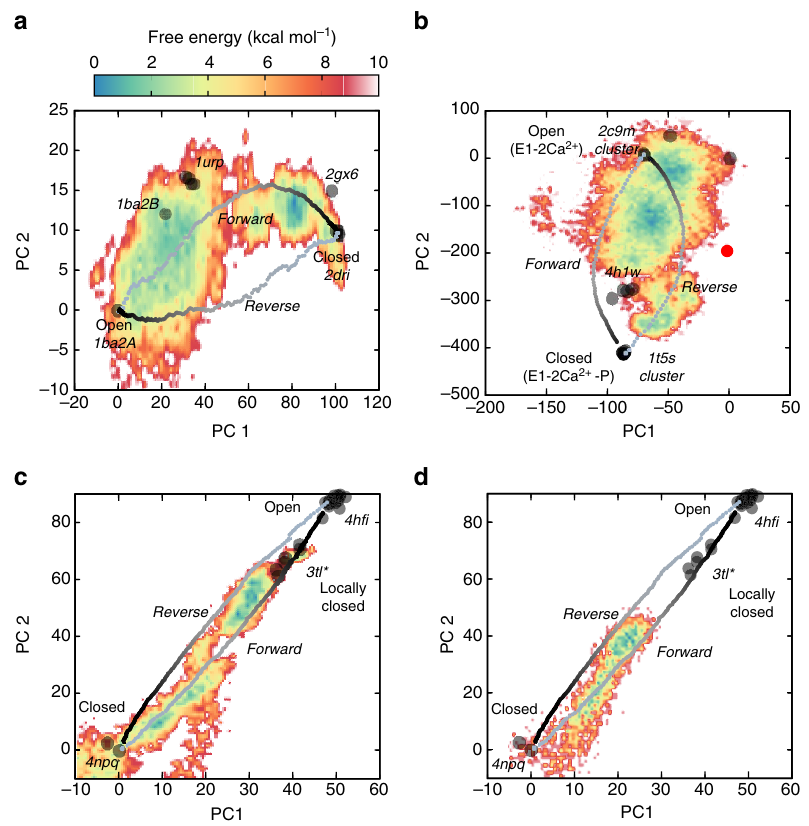
Figure 9 | Overlap of eBDIMS forward and reverse pathways with free energy landscapes obtained from atomistic simulations. ( a ) RBP opening with biased MD trajectories (1 m s); ( b ) SERCA headpiece spontaneous closing in multi-run MD simulations from the open conformation 1su4 (2 m s) reaching the intermediate state cluster; ( c ) GLIC spontaneous closing in a single long 1 m s-simulation at pH ¼ 7 and ( d ) opening in a 500ns simulation at pH ¼ 4.6. Note that the slightly divergent pathways enclose most of the lowest energy passage between the end-states, with the approached crystallographic intermediates distributed at the